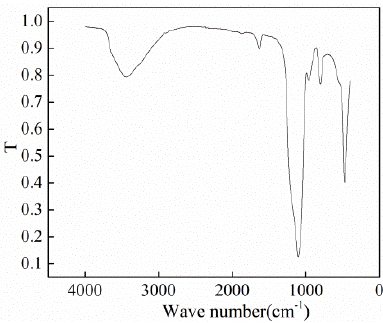
Figure 2. Morphology of NPs [43].